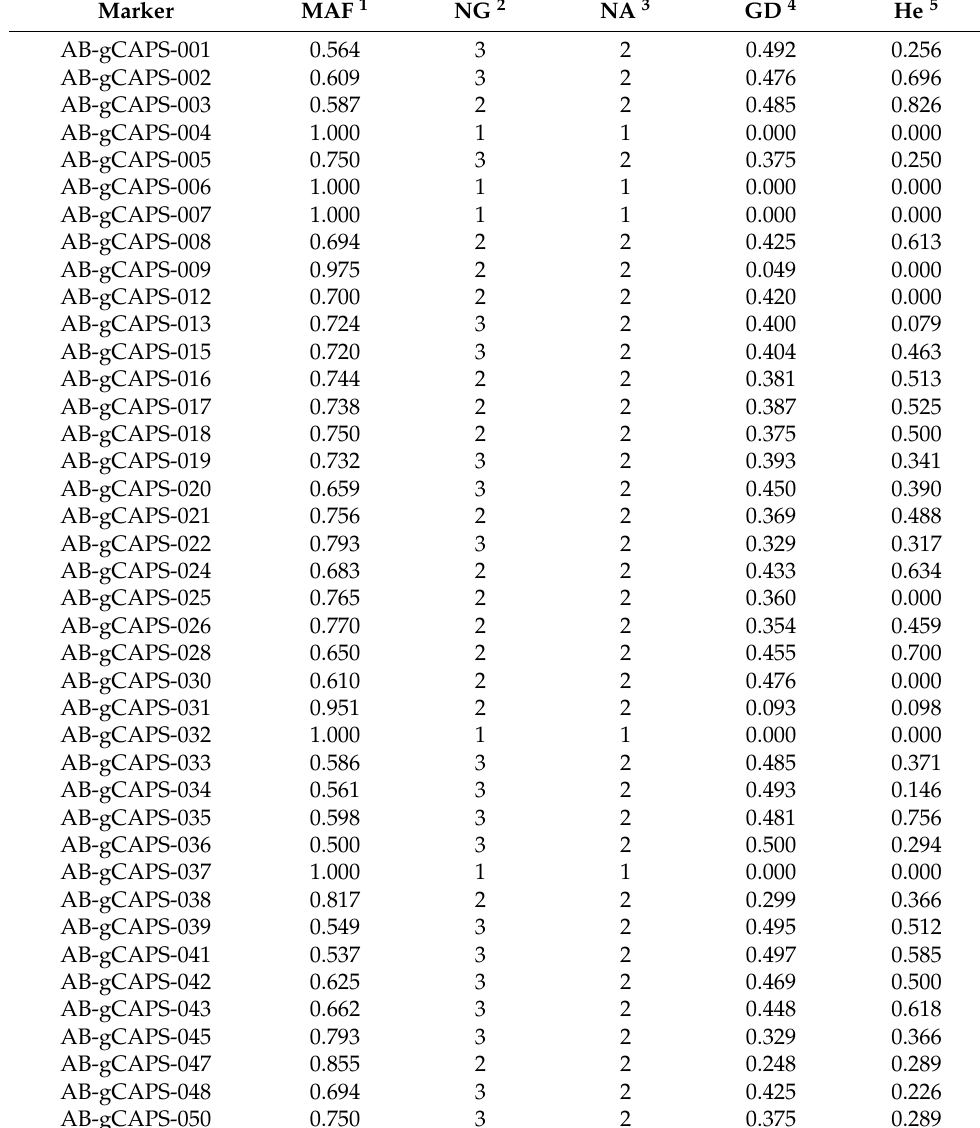
Table 3. Genetic diversity index of 41 Agaricus bisporus accessions assessed with 70 CAPS